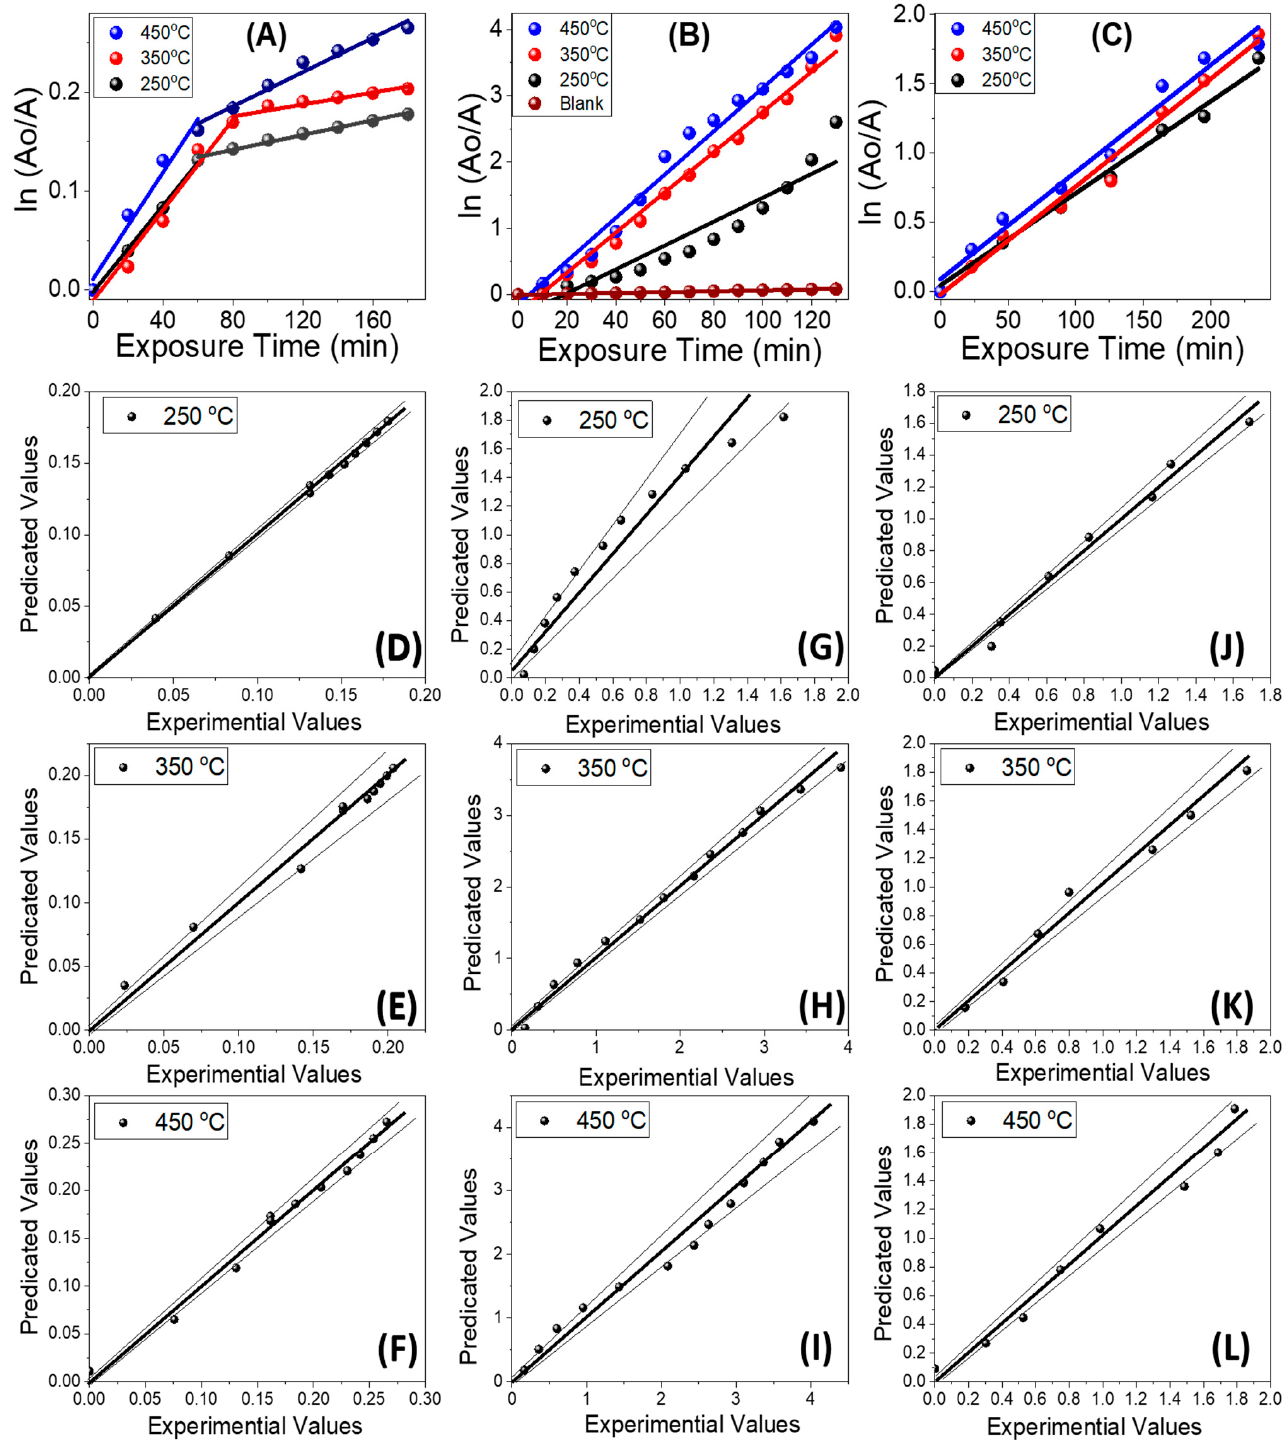
Figure 7. Kinetic study on the catalytic photodegradation of ( A ) MO and ( B ) MB under sunlight using samples before annealing and ( C ) MB using the samples after annealing at 500 °C, and the corresponding parity plots of experimental values and predicted values at ( D – J ) 250 °C, ( E – K ) 350 °C, and ( F – L ) 450 °C.